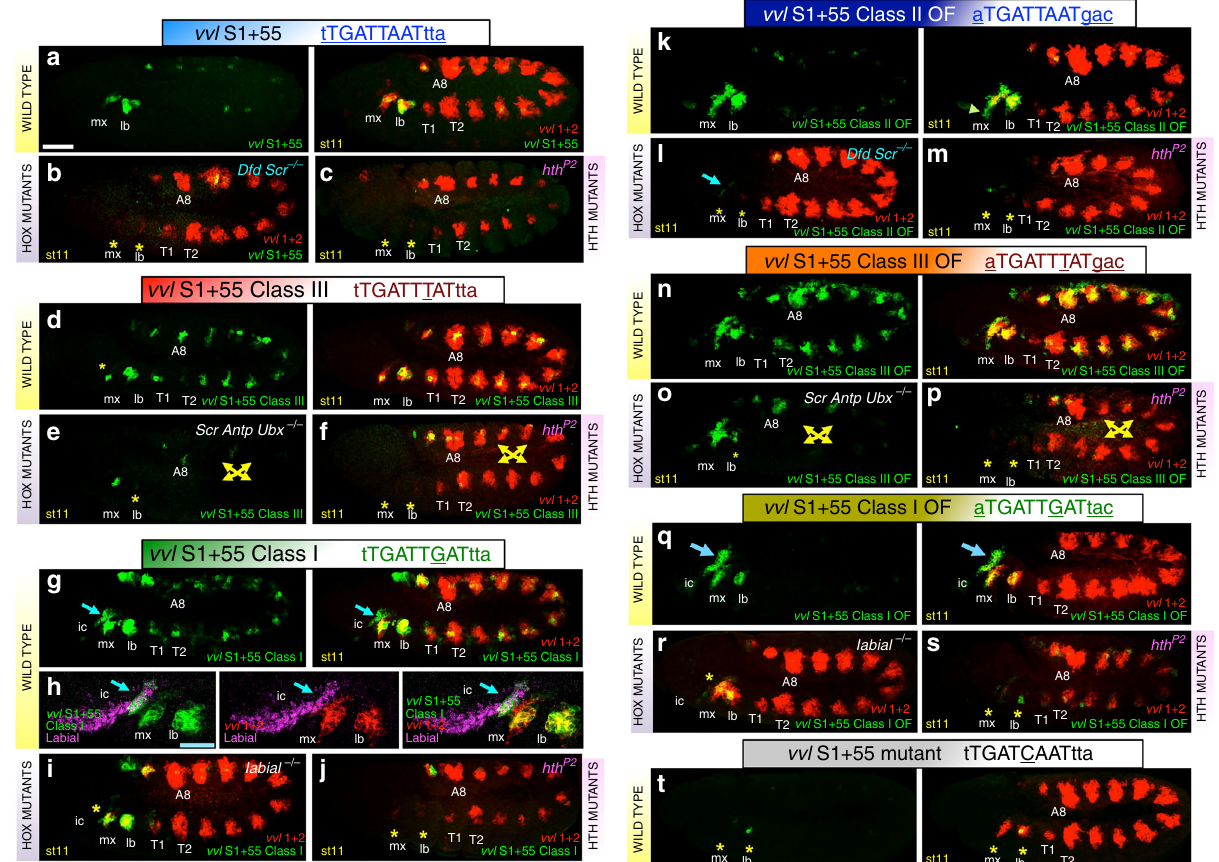
Fig. 2 Expression of S1 + 55 variants and vvl1 + 2 in wild type and mutant backgrounds. Expression of S1 + 55 class 2 reporter ( a , left panel) compared to that of vvl1 + 2 ( a , right panel) in wild type, Dfd Scr ( b ) or hth P2 ( c ) mutant embryos. Asterisks mark the segments where S1 + 55 expression is lost. Expression of S1 + 55cl3 class 3 containing reporter ( d , left panel) compared to that of vvl1 + 2 in wild type ( d , right panel), and its expression in Scr Antp Ubx ( e ) or hth P2 ( f ) mutant embryos. Yellow arrows mark the segments where S1 + 55cl3 expression is lost. Note the maxillary expression in e is in the Dfd domain, which should not be affected in this genotype. Expression of S1 + 55cl1 class 1 reporter ( g , left panel) compared to that of vvl1 + 2 in wild type ( g , right panel). Blue arrow marks the additional intercalary (ic) segment patch where vvl1 + 2 is not expressed. h Close-up of S1 + 55cl1 expression (green) in the intercalary segment stained with anti-Lab antibody (purple) compared to vvl1 + 2 (red) expression. Intercalary S1 + 55cl1 expression is lost in lab mutant ( i ) or hth P2 ( j ) mutant embryos. k Expression of S1 + 55cl2OF class 2 optimal fl anks reporter compared to that of vvl1 + 2 in wild type ( k , right panel); Dfd Scr ( l ) or hth P2 ( m ) mutant embryos. Arrowhead in ( k , right panel) points to expression outside the normal vvl1 + 2 domain. Asterisks in l – m mark the segments where S1 + 55cl2OF expression is lost. n Expression of S1 + 55cl3OF reporter compared to that of vvl1 + 2 in wild type ( n , right panel); Scr Antp Ubx ( o ) or hth P2 ( p ) mutant embryos. Yellow arrows mark the segments where S1 + 55cl3OF expression is lost. q Expression of S1 + 55cl1OF reporter compared to that of vvl1 + 2 in wild type ( q , right panel). Blue arrow marks the intercalary segment not expressing vvl1 + 2 and exhibiting extended Lab expression. Intercalary S1 + 55cl1OF expression is lost in lab ( r ) or hth P2 ( s ) mutant embryos. Expression of S1 + 55mut ( t ), a Hox-cofactor mutant site reporter, compared to that of vvl1 + 2 in wild type embryos ( t , right panel). White scale bar 50 μ m. Blue scale bar 25 μ m. All embryos shown in these and following fi gures are at stage 11